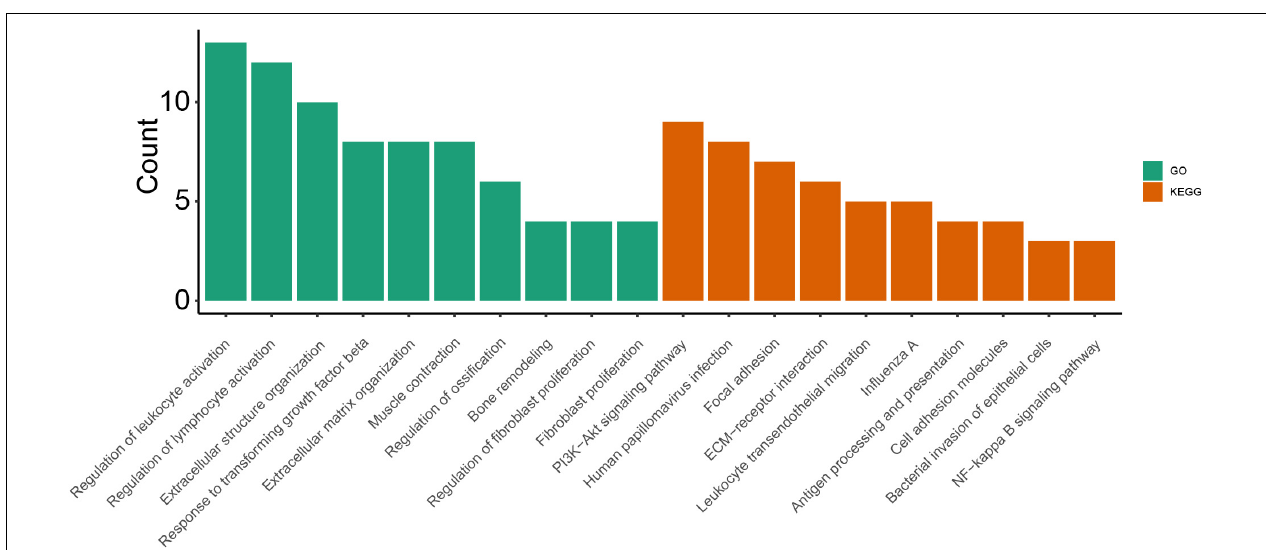
FIGURE 2 | Enriched GO terms and KEGG